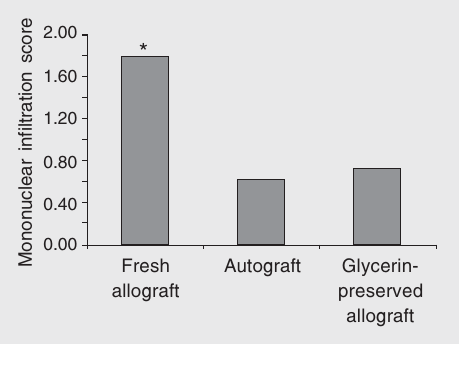
Figure 4. Photomicrograph of the tracheal allograft trans- planted into the greater omen- tum after 28 days. Intense mono- nuclear infiltration is seen in the tracheal adventitia and perivas- cular space (hematoxylin-eosin; 100X).